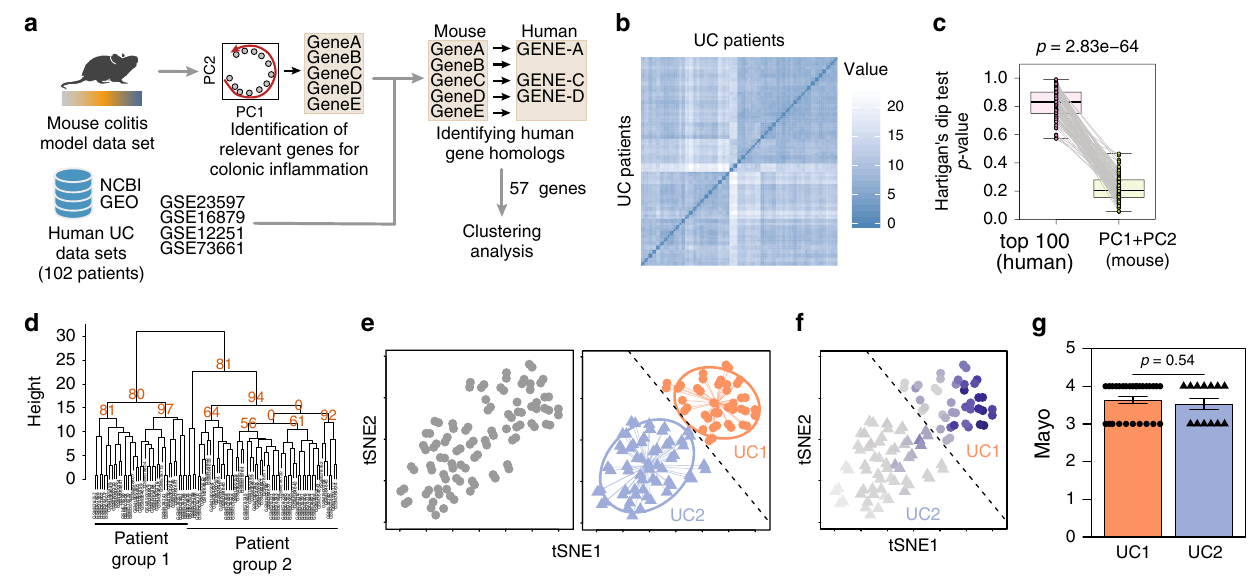
Fig. 3 Conserved in fl ammatory gene signature distinguishes two UC transcriptomic pro fi les. a Schematic representation of the strategy used for patient group identi fi cation. Four publicly available data sets were combined. Gene ranking was done using the most variable genes-identi fi ed mouse data set that had a homolog in humans. b Sample dissimilarity heatmaps for visual analysis of clustering tendency (VAT), comparing the human data set using the top mouse gene homologs. c Hartigan ’ s Dip test for clustering tendency comparing the analysis using the top 100 variable genes and the top mouse gene homologs. d Bootstrapping analysis of hierarchical clustering, comparing the human data set using the top mouse gene homologs. Numbers in orange indicate the approximately unbiased (AU) p -value, shown as percentage. AU closer to zero indicates a cluster with low stability. e t-SNE plot using the top variable genes identi fi ed from the mouse data set. Each point represents a patient sample. t-SNE plot showing the separation of two patient pro fi les (left). Unsupervised hierarchical agglomerative clustering was used to automatically de fi ne patient subdivision (center). Dashed line delimits UC1 (triangle) and UC2 (circles) patients. f Average expression of mouse homolog genes used to subdivide patients, where the dark blue color indicates a higher average expression. Dashed line delimits UC1 (triangle) and UC2 (circles) patients. g Assessment of Mayo clinical subscore in patients from UC1 and UC2. Mann – Whitney test was used for comparison. Boxplot represent the median (center line, second quantile), fi rst, and third quantiles (box) and whiskers extending 1.5 times the interquartile range (IQR). Error bars represent the standard